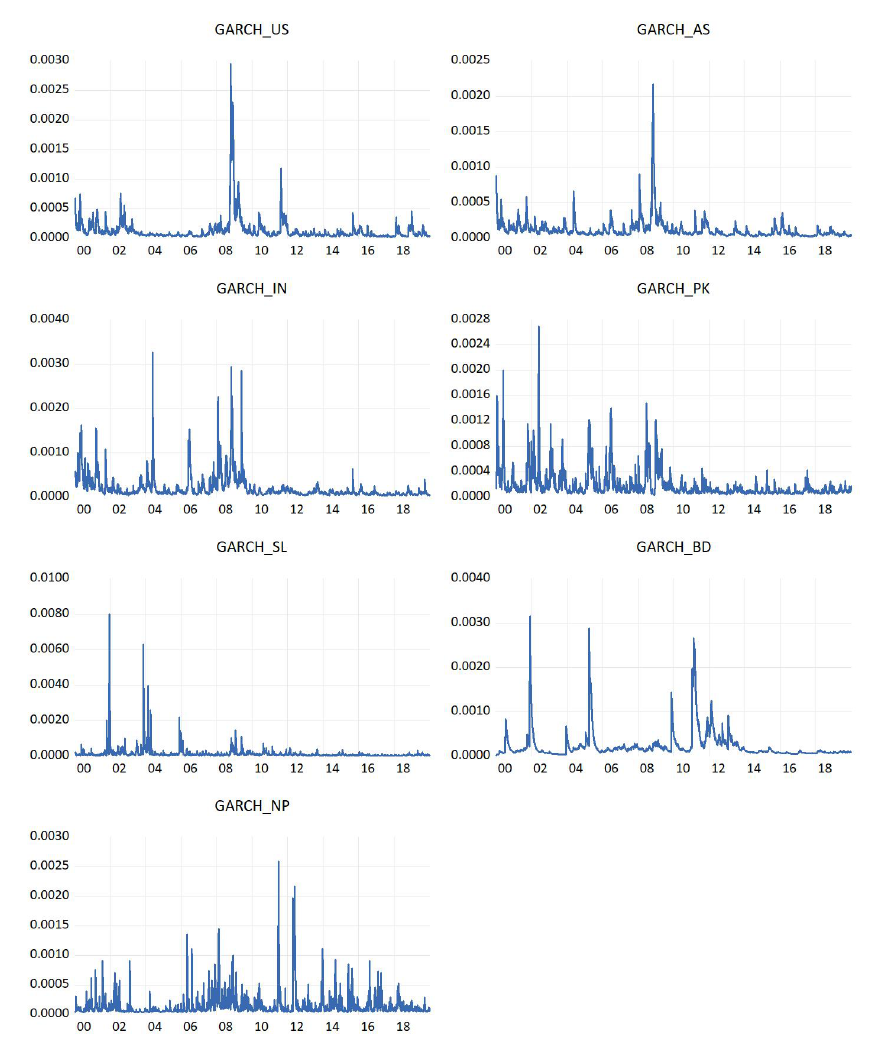
Figure 3. Conditional variances. This graph shows the conditional variances of the aggregate equity market indices for the sample countries. GARCH_US, GARCH_AS, GARCH_IN, GARCH_PK, GARCH_SL, GARCH_BD and GARCH_NP refer to conditional variances for the equity return series of the US, Asia, India, Pakistan, Sri Lanka, Bangladesh, and Nepal respectively. The sample period is from 4 January 2000 to 31 December 2019. In each panel, x-axis shows the time and y-axis shows the conditional variance. The conditional variances are estimated as GARCH(1,1) process with the mean equation: r i , t = µ + e i , t